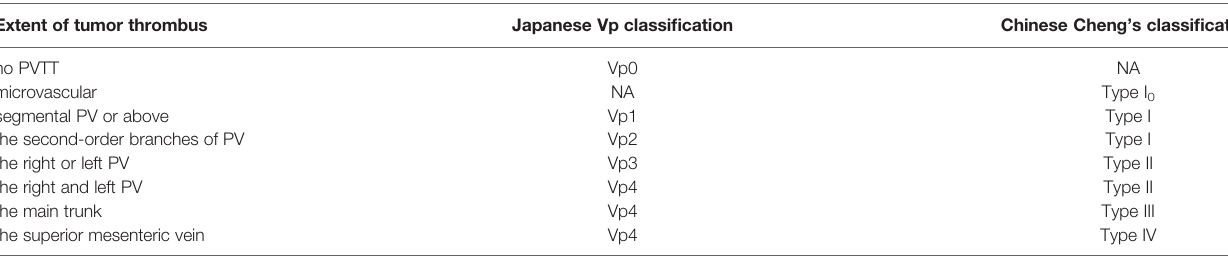
TABLE 1 | Classi fi cations of